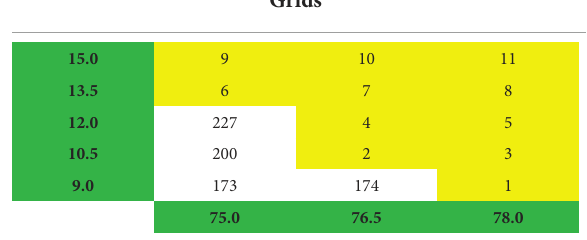
TABLE 2 Geographical grid details used in the study region highlighted in yellow (for interpretation of the references to color in this figure, the reader is referred to the web version of this